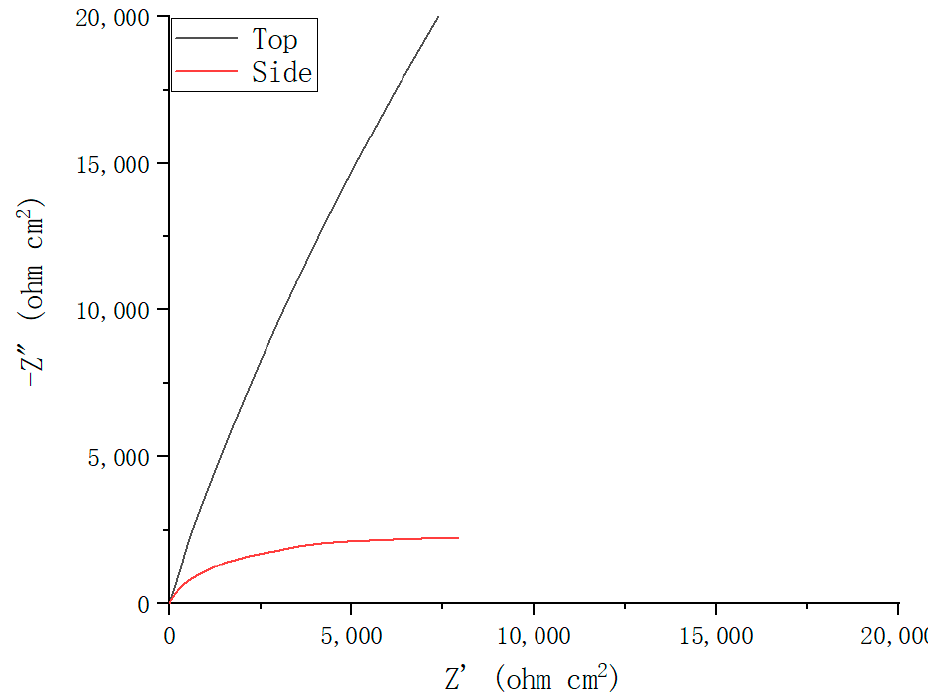
Figure 5. The EIS spectra of top surface and side surface.